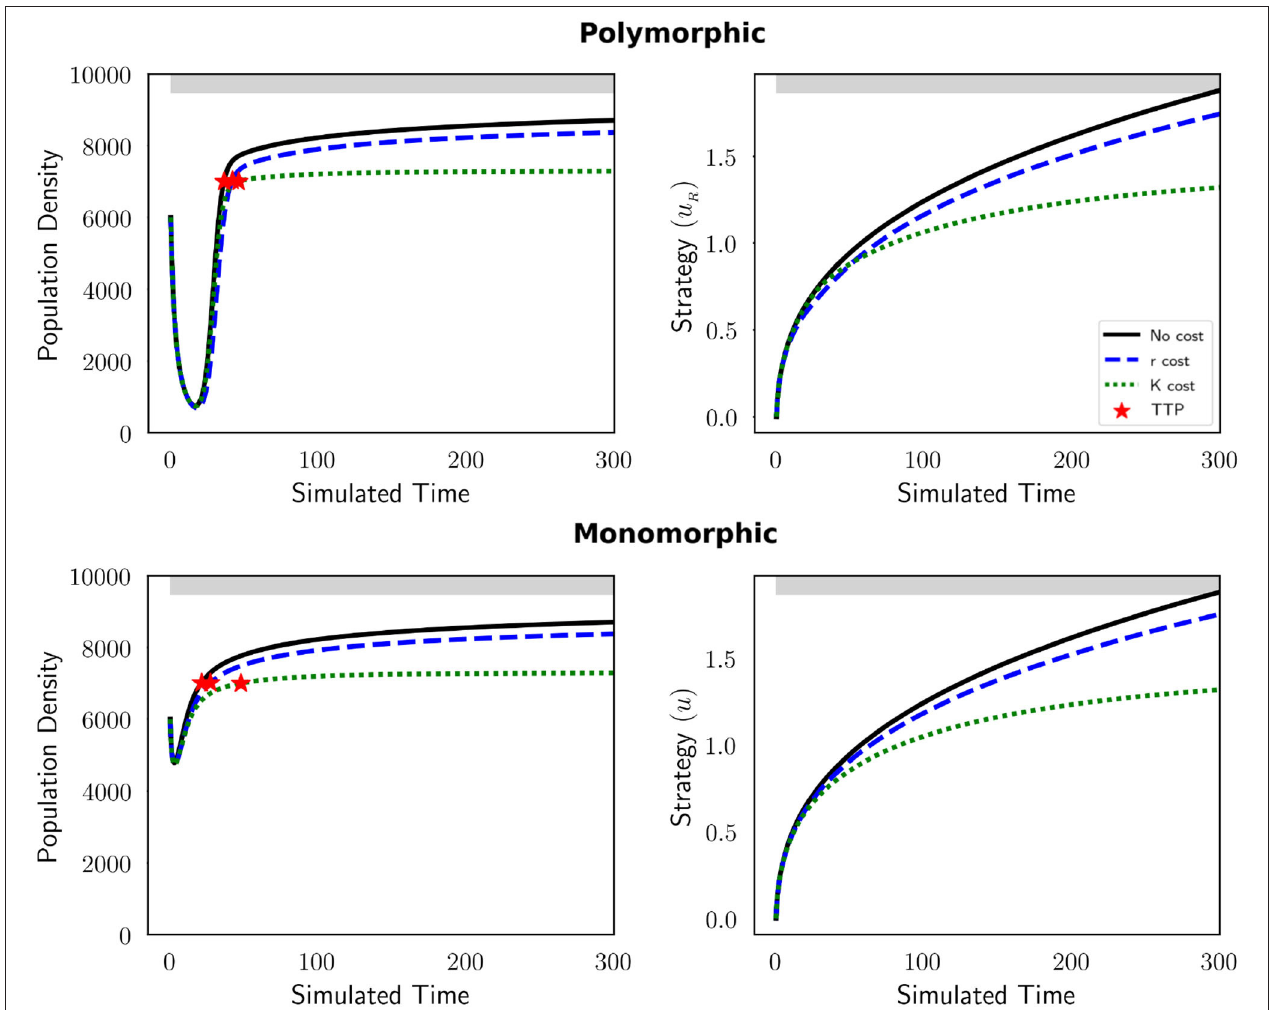
FIGURE 1 | The presence of a resistance cost can improve the short-lived therapeutic success of MTD treatment. Drug administration is shown at the top of each plot in gray. Population dynamics (left) and the evolutionary dynamics (right) are shown in the absence of a resistance cost (black solid line), and when the cost is manifested in the intrinsic growth rate (blue dashed) and carrying capacity (green dot dashed line) for a polymorphic (top) and monomorphic (bottom) tumor cell population. The strategy in the polymorphic context is that of the resistant population of cells. Red stars indicate progression defined as x ≥ 7,000. When a cost of resistance is imposed on carrying capacity there is a greater extension in TTP. The parameters used in these figures are: m = 1, K max = 10,000, r max = 0.45, k = 2, b = 10, d = 0.01, g = 0.1, σ =